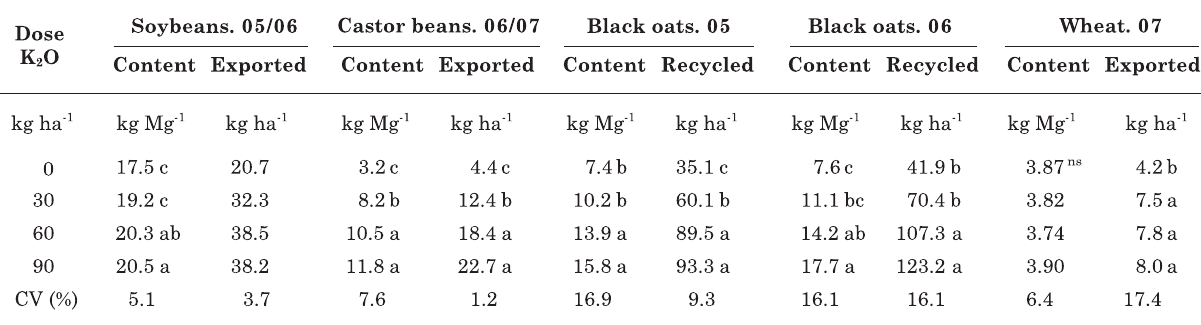
Table 3. Potassium content in the grain and quantities exported by wheat, soybeans and castor beans and content and quantity recycled by the above ground part of black